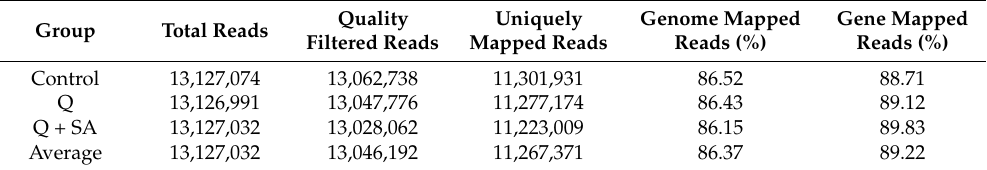
Table 1. Summary of average sequencing data for each group.